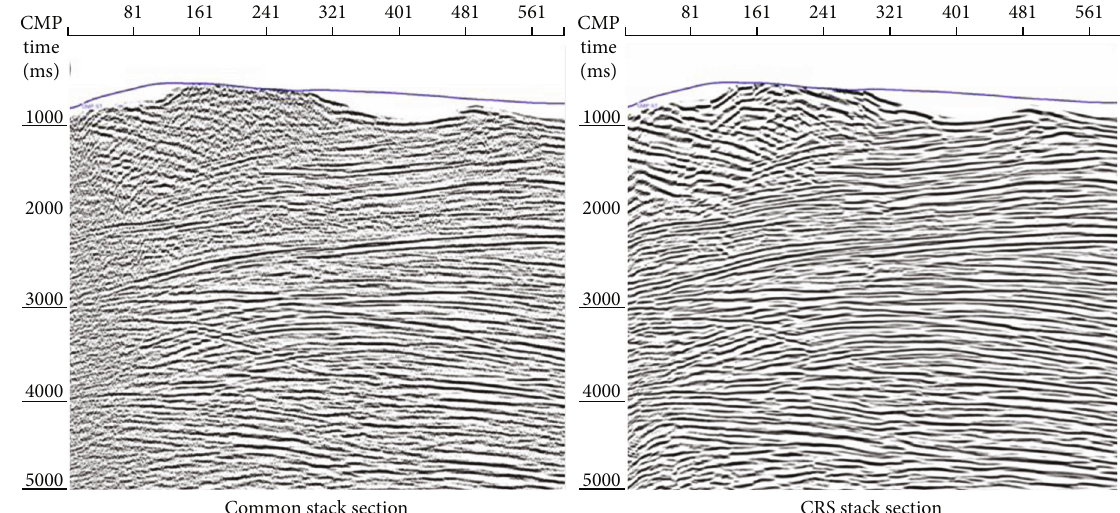
Figure 15: The comparison between the common stack section and CRS-stack section